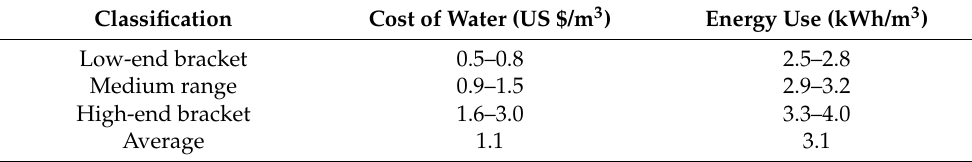
Table 3. Typical costs and energy use of desalination systems. Taken from